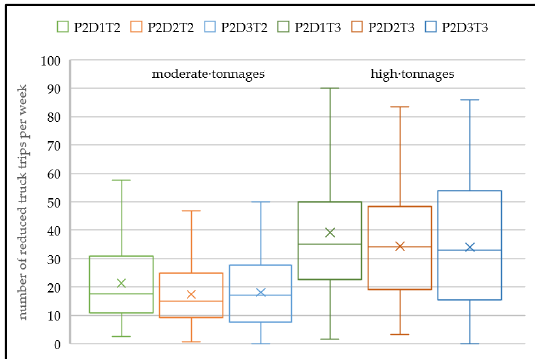
Figure 5. Reduced truck trips for one train pick-up. P = train wagons pick-ups: P1 = one a day, P2 = two a day. T = tonnage of forest trucks equipped with crane: T1 = low, T2 = moderate, T3 = high. D = delivery time to train terminal: D1 = short, D2 = medium, D3 = long.